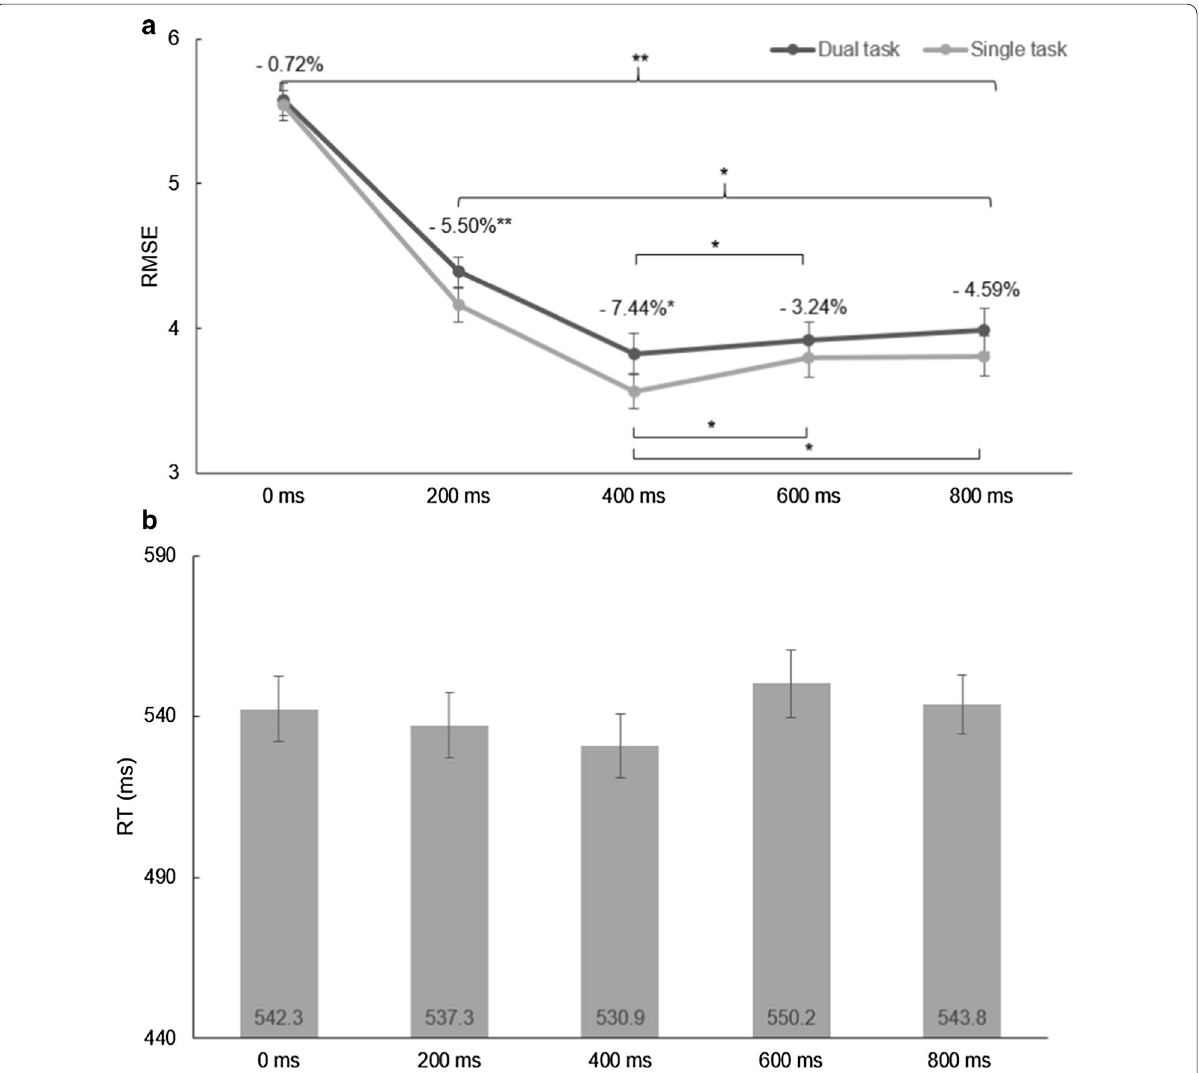
Fig. 3 Performance on the 6 predictability conditions. a Tracking performance in Experiment 1 as indicated by root-mean-square error (RMSE). The light gray line represents mean RMSE for dual-task conditions, the dark gray line single-task conditions. Asterisks denote significant differences between single- and dual-task conditions. Dual-task costs, which are added to the graph as percentages, were significantly reduced in the 200-ms and 400-ms conditions. b Reaction times in dual-task conditions. Asterisks denote significant differences between predictability conditions. Conditions varied in predictability (i.e., length of the visible path) from 0 to 800 ms. In both panels, error bars show the standard